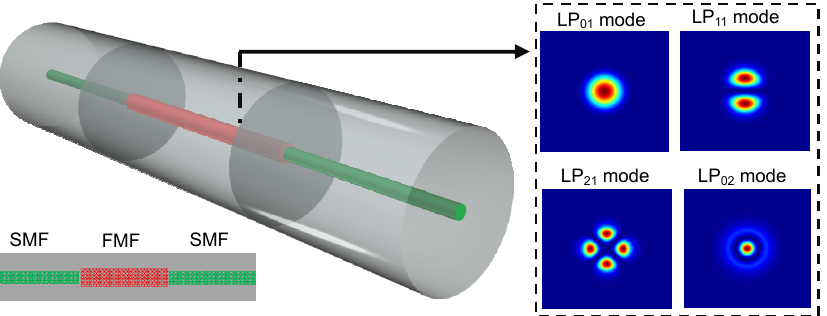
Fig. 2 | The schematic diagram of FMF in-line interferometers based on the structure of SMF-FMF-SMF, and the intensity distribution of modes supported in FMF, namely LP 01 , LP 11 , LP 02 and LP 21 modes.